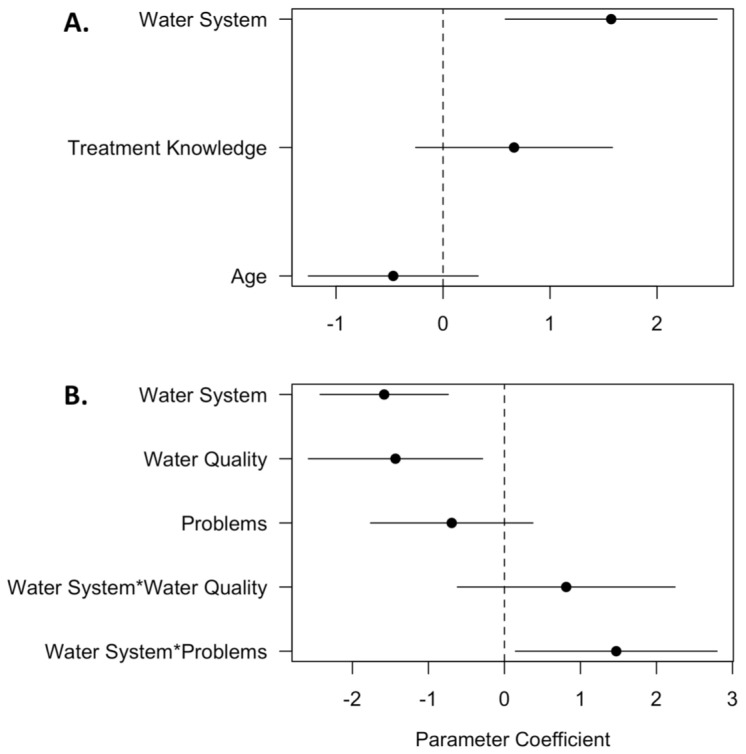
Parameter Estimate Plot of All Variables Considered in the Two Models that Predict Household Water Management Strategies.Standard errors are plotted as black lines. The variable is significant if standard error bars do not cross the zero axis. For the number of water sources (A), institution type is significant (p<0.005). For whether households treat water (B), institution type (p<0.001), perceptions of water quality (p<0.05), and the interaction between institution type and if households have a problem with institutional management (p<0.05) are significant.